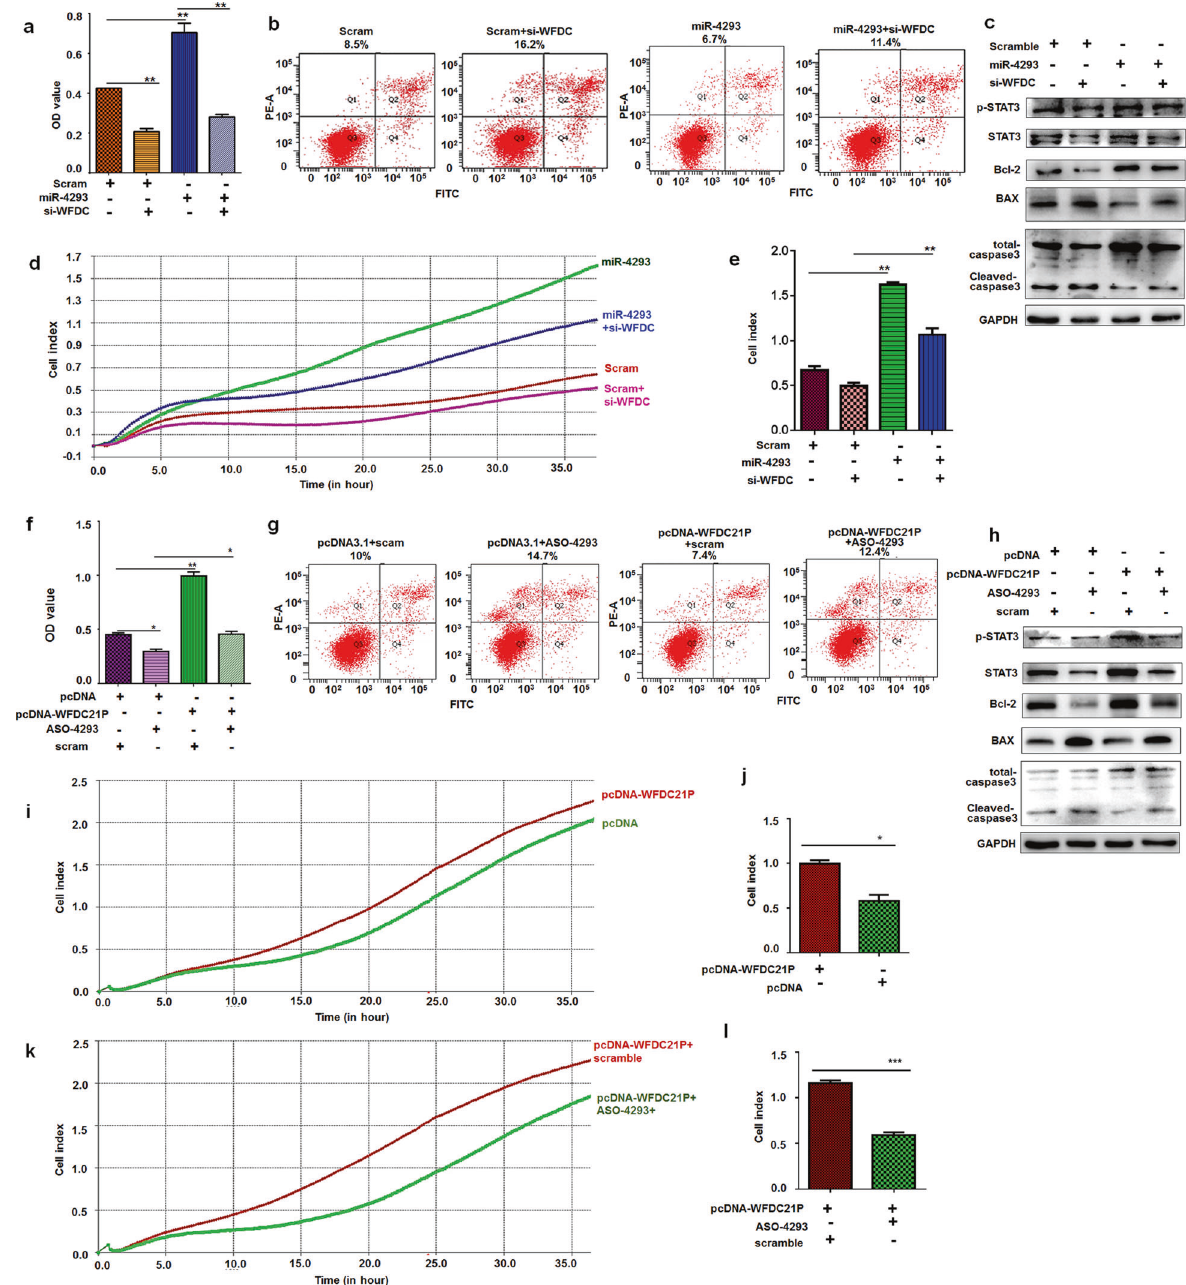
Fig. 5 miR-4293 function was attenuated by blocking WFDC21P. The above-mentioned data showed that miR-4293 transfection elevated miR-4293 levels, which could be attenuated by ASO. pcDNA-WFDC21P transfection increased WFDC21P. Si-WFDC treatment reduced WFDC21P level. a MTT assay of A549 at 24 h post-transfection of si-WFDC + scramble, miR-4293, miR-4293 + si-WFDC, and scramble. Data are expressed as mean ± SD for triplicate experiments. ** p < 0.01; ANOVA test. b FACS analysis of A549 cell apoptosis at 24 h post-transfection of si-WFDC + scramble, miR-4293, miR-4293 + si-WFDC, and scramble. c Western blot detection p-STAT3, Bcl-2, BAX, cleaved-caspase 3, 8, and 9 in si-WFDC + scramble-, miR-4293-, miR-4293 + si-WFDC- or scramble-treated cells. d , e RTCA station analysis of migration for A549 with transcription of si-WFDC + scramble-, miR-4293-, miR-4293 + si-WFDC- or scramble. f MTT of A549 at 24 h post-transfection of pcDNA + ASO- 4293, pcDNA-WFDC21P + scramble, pcDNA-WFDC21P + ASO-4293, and pcDNA + scramble. Data are expressed as mean ± SD for triplicate experiments. (* P < 0.05). g FACS analysis of A549 cell apoptosis at 24 h post-transfection of pcDNA + ASO-4293, pcDNA-WFDC21P + scramble, pcDNA-WFDC21P + ASO-4293, and pcDNA + scramble. h Western blot detection of STAT3 phosphorylation and apoptosis-related factors (Bcl- 2, Bax and Caspase 3) in pcDNA + ASO-4293, pcDNA-WFDC21P + scramble, pcDNA-WFDC21P + ASO-4293, and pcDNA + scramble-treated A549 cells. i – l RTCA station analysis of migration for A549. i , j pcDNA-WFDC21P vs pc-DNA; ( k ) and ( l ), pcDNA-WFDC21P + scramble vs. pcDNA-WFDC21P + ASO-4293. Data are expressed as mean ± SD for triplicate experiments. * p < 0.05, *** p < 0.001; Student ’ s t